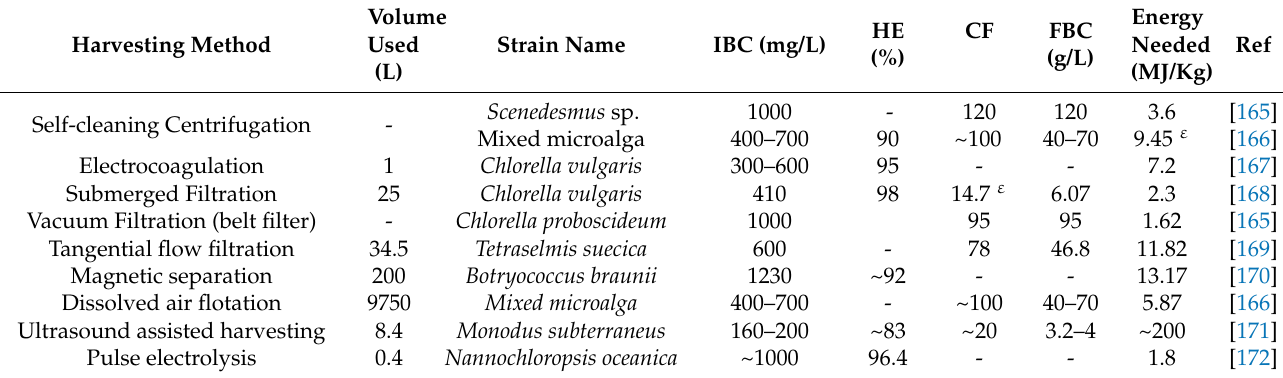
Table 4. Energy requirement in microalgae biomass